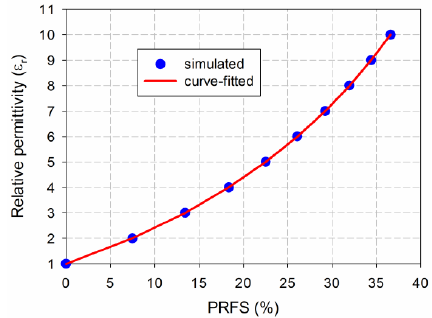
Figure 6. Simulated and curve-fitted relative permittivity of the MUT as a function of PRFS for the proposed MLS-loaded MPSA.